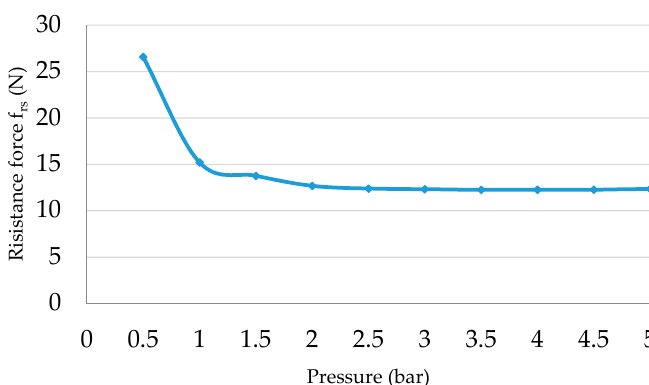
Figure 11. The resistance force of the third actuator against air pressure.